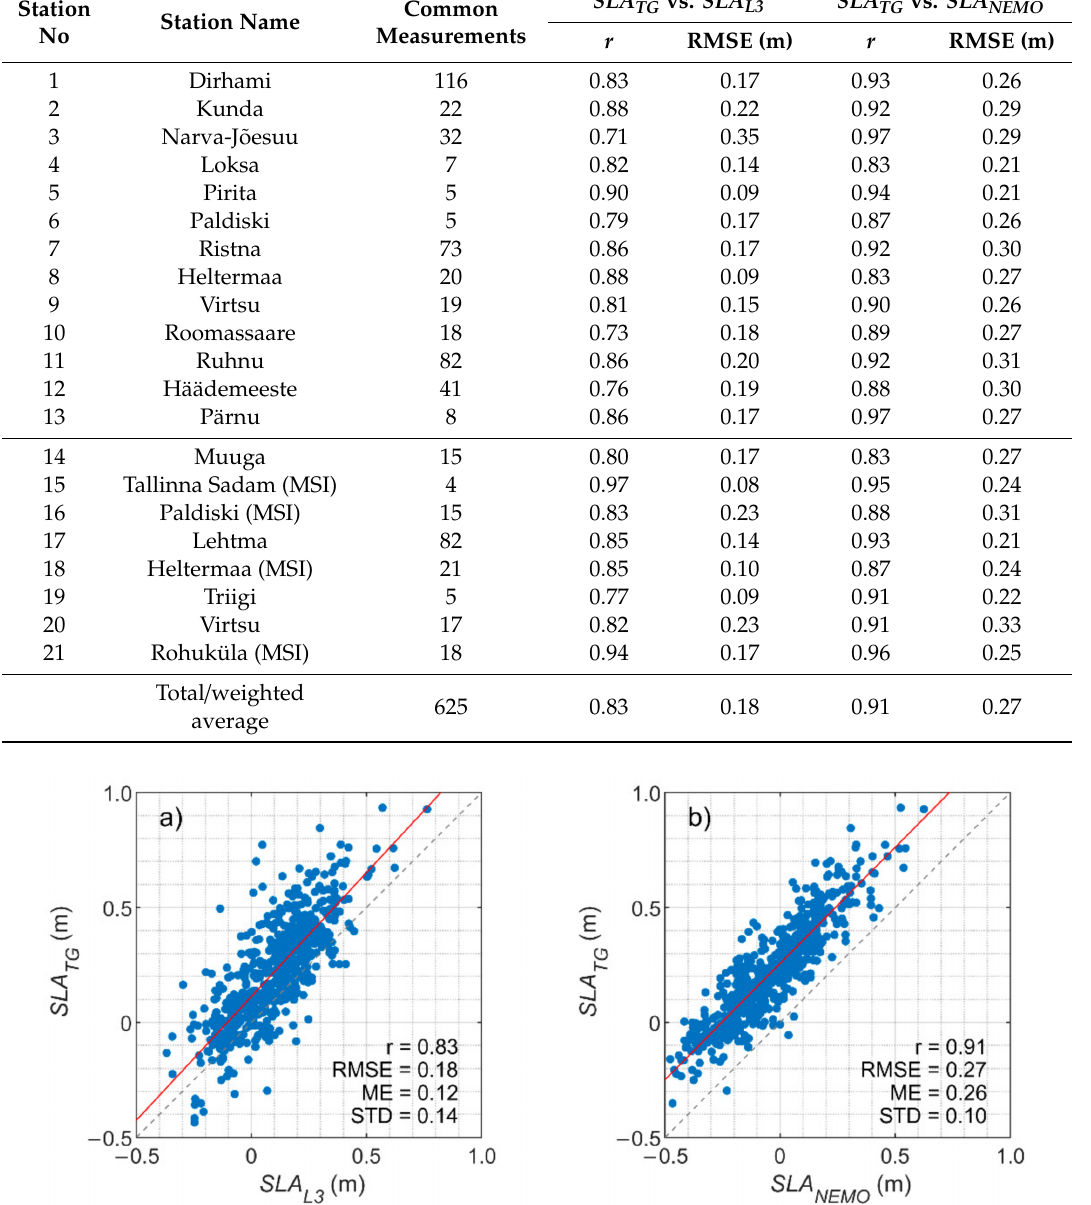
Figure 11. Comparison of tide gauge-based sea-level measurements ( SLA TG ) with ( a ) altimetry CMEMS Level 3 sea-level anomaly ( SLA L3 ) and ( b ) NEMO reanalysis model ( SLA NEMO ), respectively. The red line is the linear regression between the two